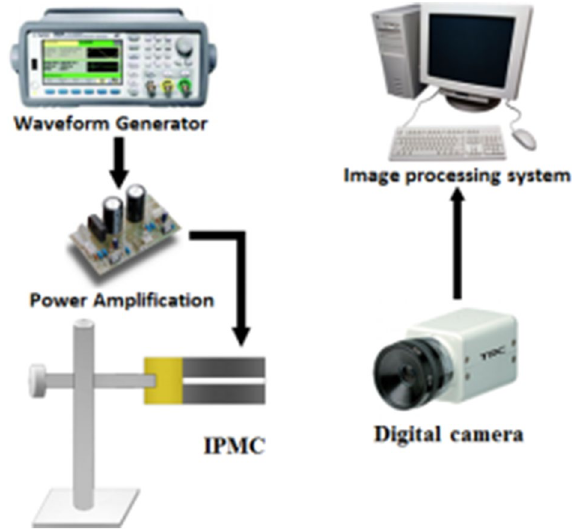
Figure 2. Torsion performance test system.